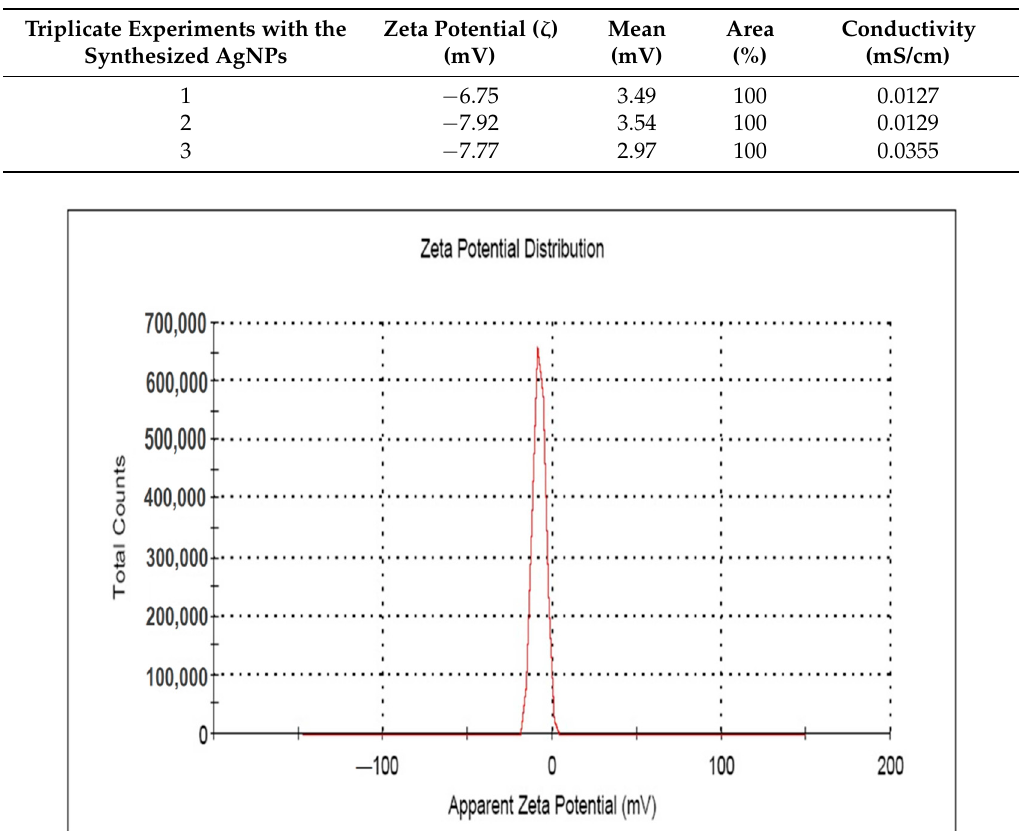
Table. 2. Zeta potential value of the synthesized AgNPs. Table 2. Zeta potential value of the synthesized AgNPs.